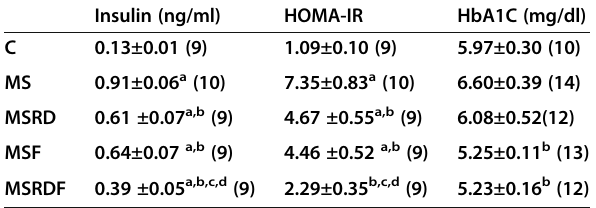
Table 3 The final glucose homeostasis parameters in the five study